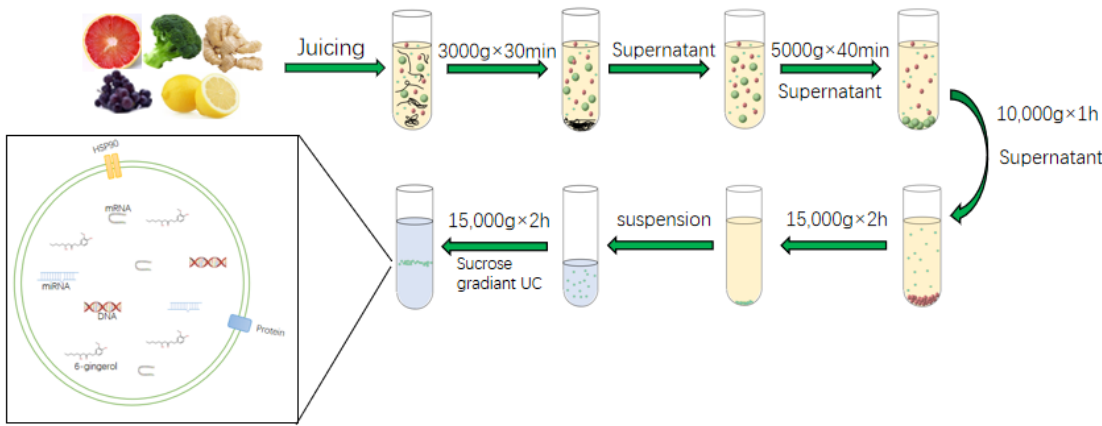
Figure 3. Isolation and Preparation of plant derived EVs.